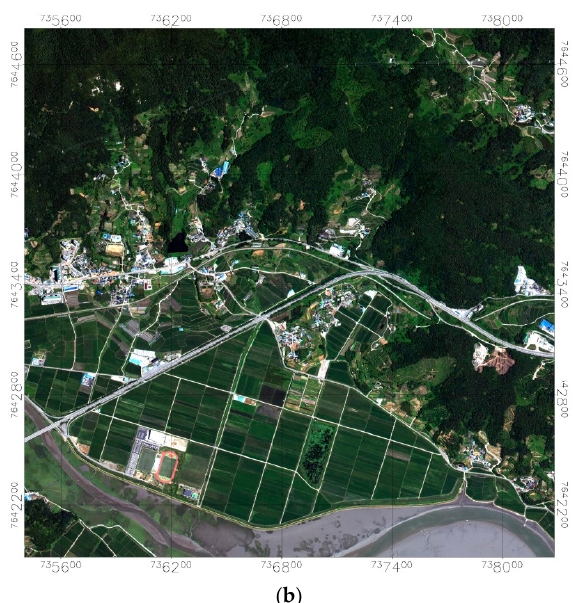
Figure 1. Study areas for the sharpening of Worldview-3 satellite images: ( a ) true color composite of site 1; and ( b ) true color composite of site 2.